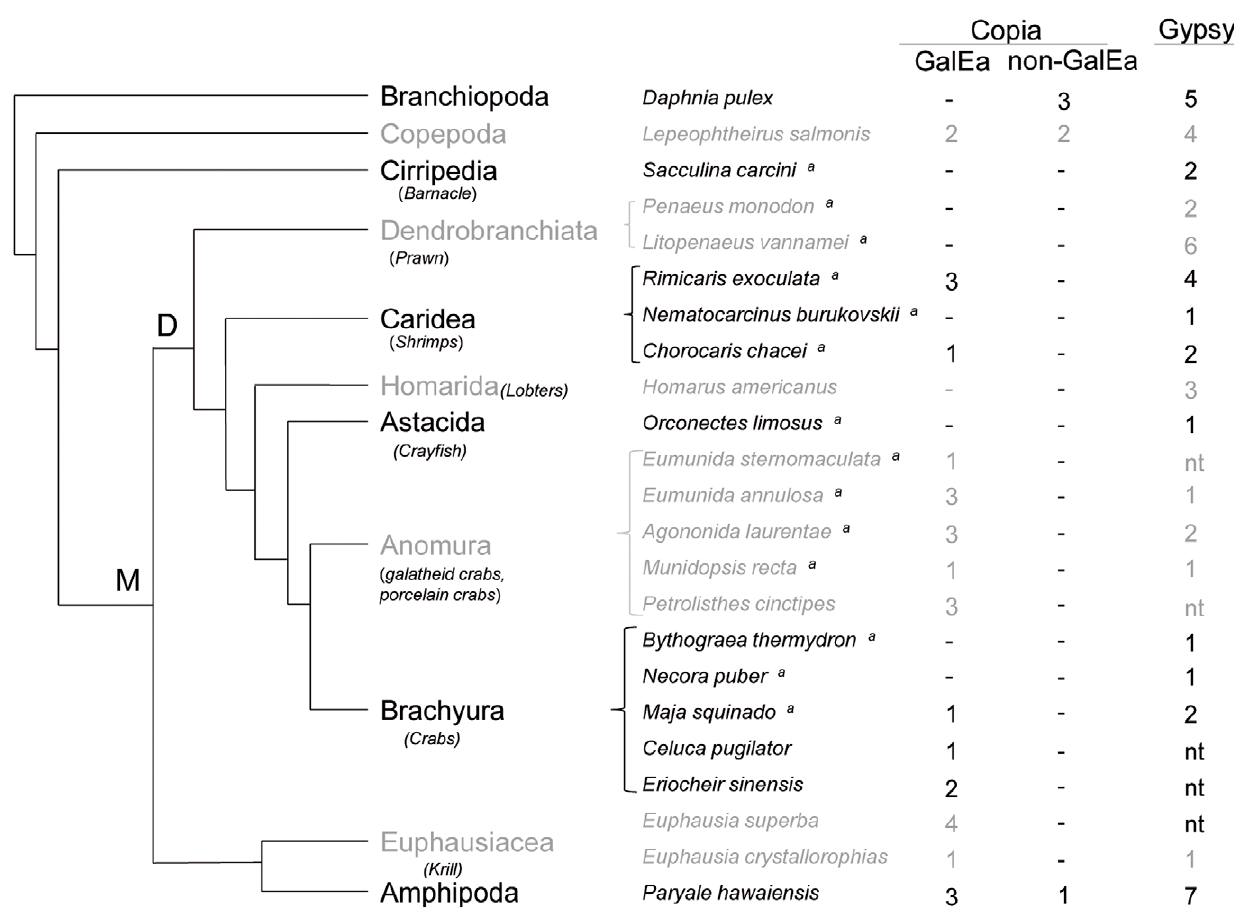
Figure 2. Number of Copia and Gypsy elements studied in crustaceans. Genetic relationships between crustacean classes and orders are represented by a tree topology reconstructed from previous studies (Regier et al. 2010, Giribet and Edgecombe, 2011; Ahyong and O’Meally, 2004). M : Malacostraca, D : Decapoda. For Copia retrotransposons, GalEa and non-GalEa elements are distinguished. Only a few representatives of the Copia elements described in D. pulex were studied. nt: not tested; -: no element detected; a species screened using degenerate PCRs.